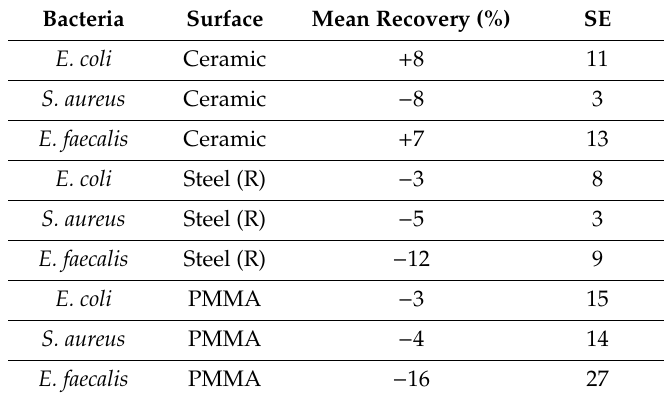
Table 2. Residual antimicrobial activity of biocide. “+” value indicates increase in bacterial recovery versus control; “ − “indicates a reduction in the number of bacteria recovered versus the control. SE indicates the standard error of the mean. These values were not different from the control or each other at a statistically significant level ( p > 0.05). Steel (R) denotes rough steel samples.